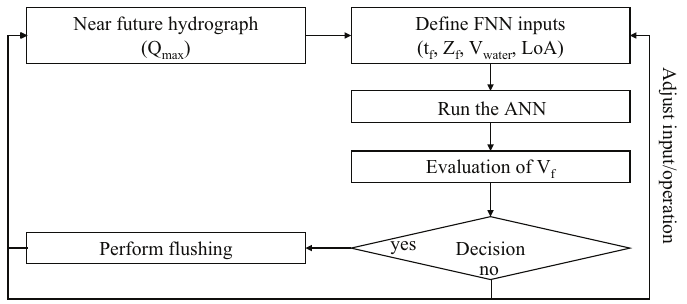
Figure 10. Integration of the developed ANN as a decision support tool for reservoir